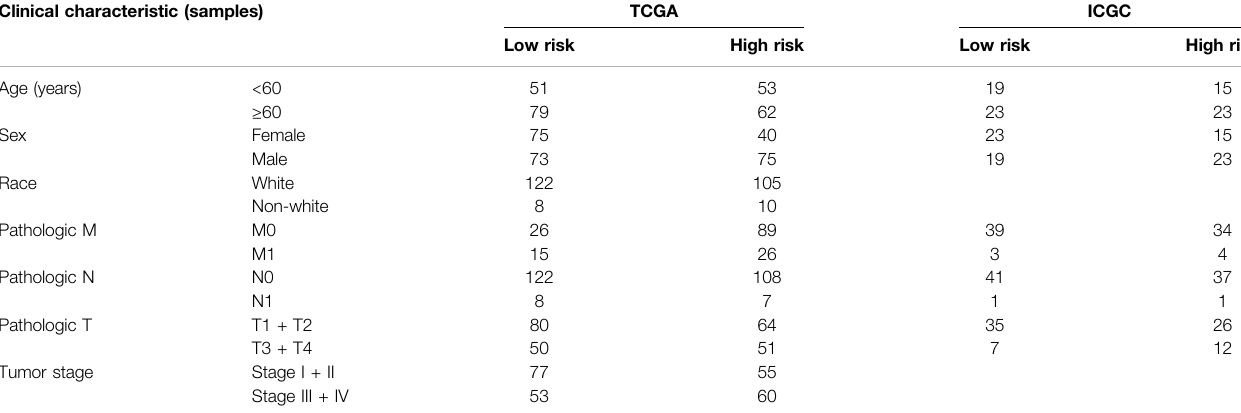
TABLE 1 | Baseline characteristics of the patients in different risk groups in TCGA and ICGC cohorts. Clinical characteristic